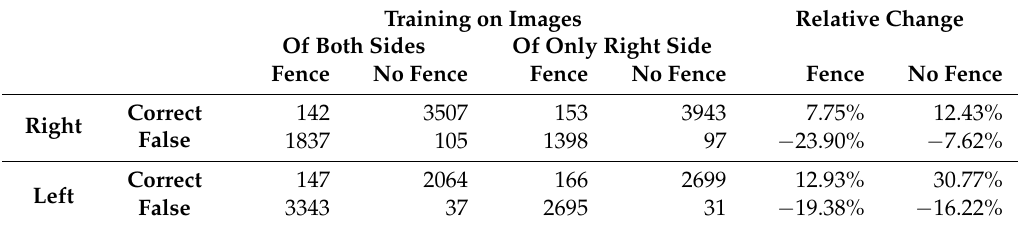
Table 6. Comparison of automatic image recognition using neural network with training of images of both sides and only right side and the relative